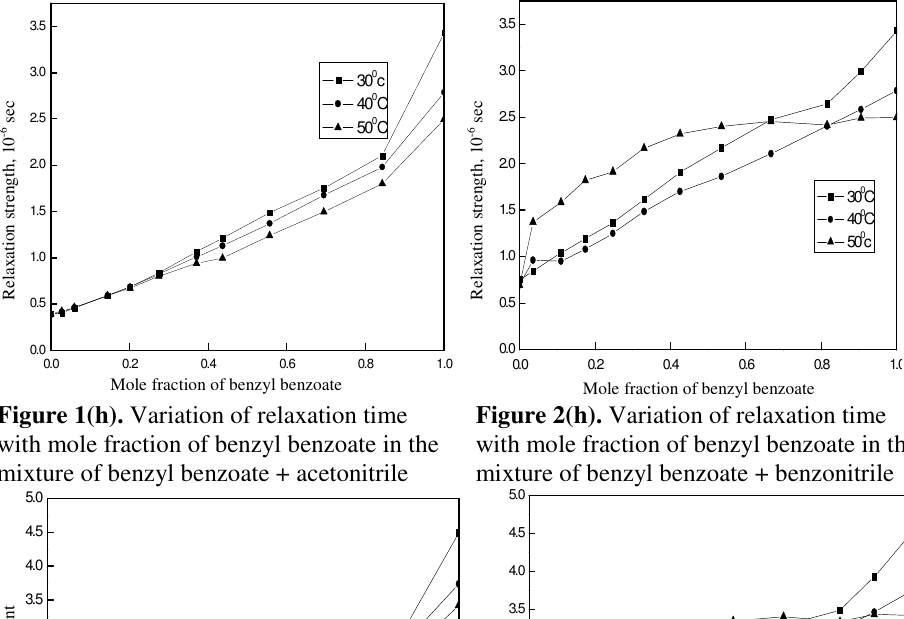
Figure 2(i). Variation of absorption coefficient with mole fraction of benzyl benzoate in the mixture of benzyl benzoate +